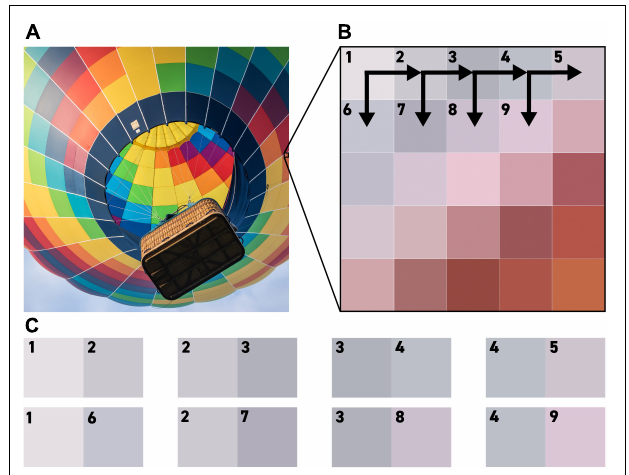
FIGURE 4 | An illustration of the methodology by which pixels from an RGB (Red, Green Blue) image are used to generate testable edges for our algorithm. Each pixel in the test image (A) is compared to the pixel to its right and the pixel below it, as seen in (B) , to generate the edges shown in (C) . Image